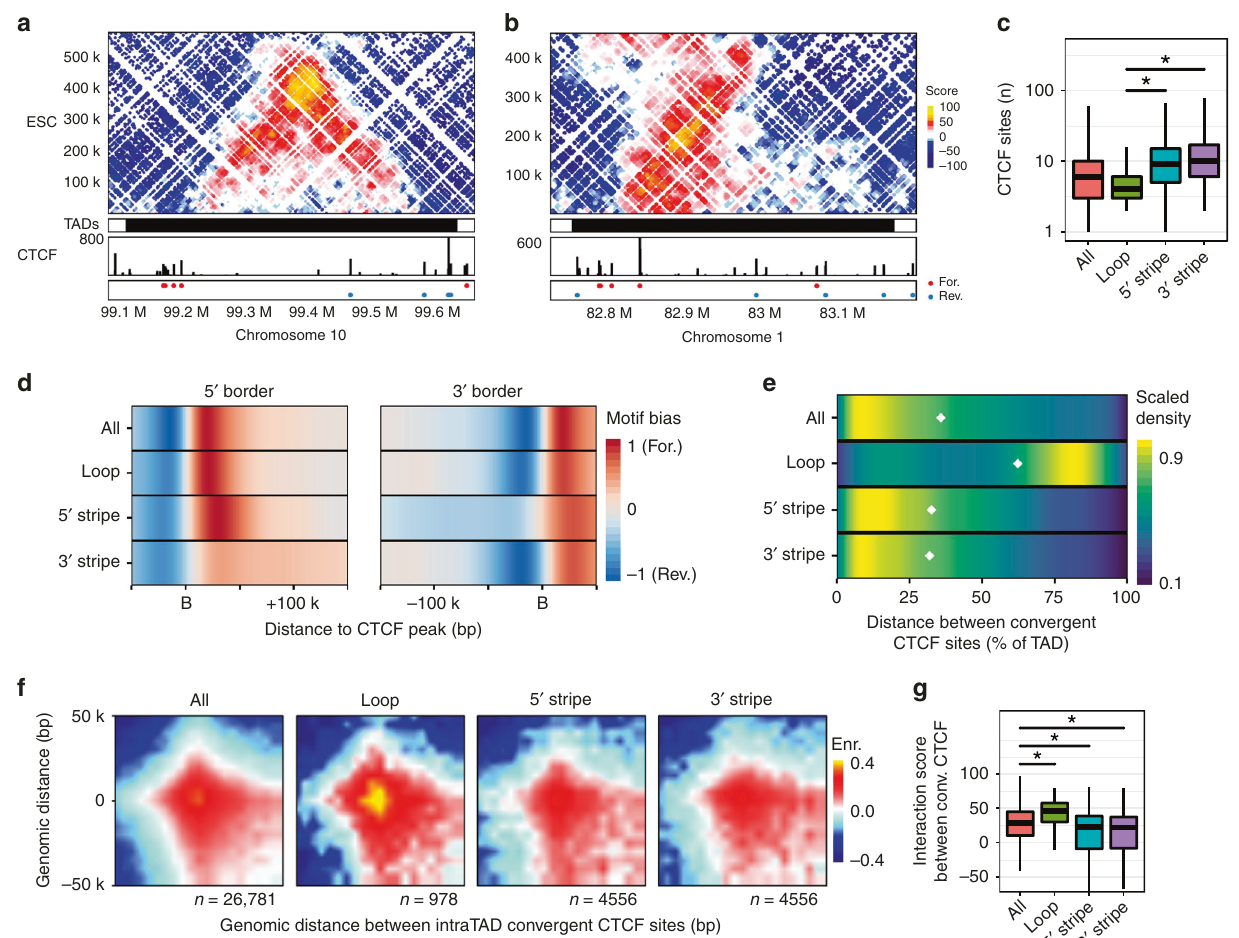
Fig. 4 CTCF occupancy and connectivity are key determinants of stripe TAD architecture. ESC Hi-C contact maps for ( a ) a 550 kb region on chr10 representative of a loop domain and ( b ) a 450 kb region on chr1 representative of a 5 ′ stripe domain. TAD calls, CTCF ChIP-seq data, and motifs at peaks are shown as before. c Distribution of the number of CTCF-binding sites in classi fi ed ESC TADs. Central bar represents the mean and whiskers and boxes indicate all and 50% of values, respectively. KS test * p < 0.001. d Distribution of bound CTCF motifs within 50 kb outside and 100 kb inside of TAD borders, separated into 5 ′ and 3 ′ borders ( ‘ B ’ on the x -axis). Colour scale represents the difference in density distribution of forward and reverse motifs. e Density distribution of distances between convergent CTCF motifs within TAD classes as a proportion of TAD size. White diamonds indicate median distances. f Aggregate Hi-C contact maps around pairs of intra-TAD convergent CTCF sites in ESCs. Pairs have a minimum interaction score of 40 within a 50 kb region. Number of pairs shown below each plot. g Quanti fi cation of interaction scores between convergent CTCF sites shown in ( f ), Box plot as in c , KS test * p <